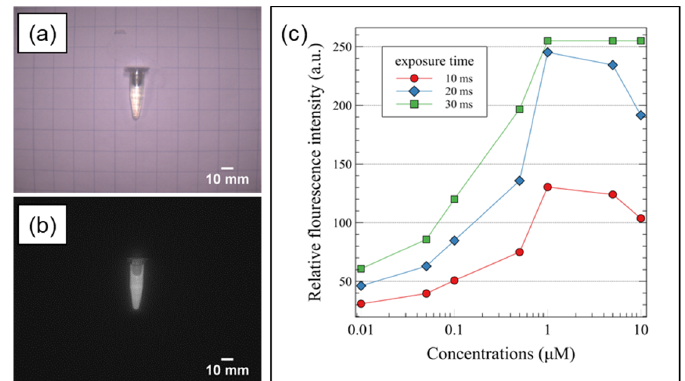
Figure 4. Sensitivity evaluation of the system ( a ) Color image of ICG solution ( b ) NIR image of ICG solution ( c ) Average fluorescence intensity from various concentrations of ICG and exposure times.